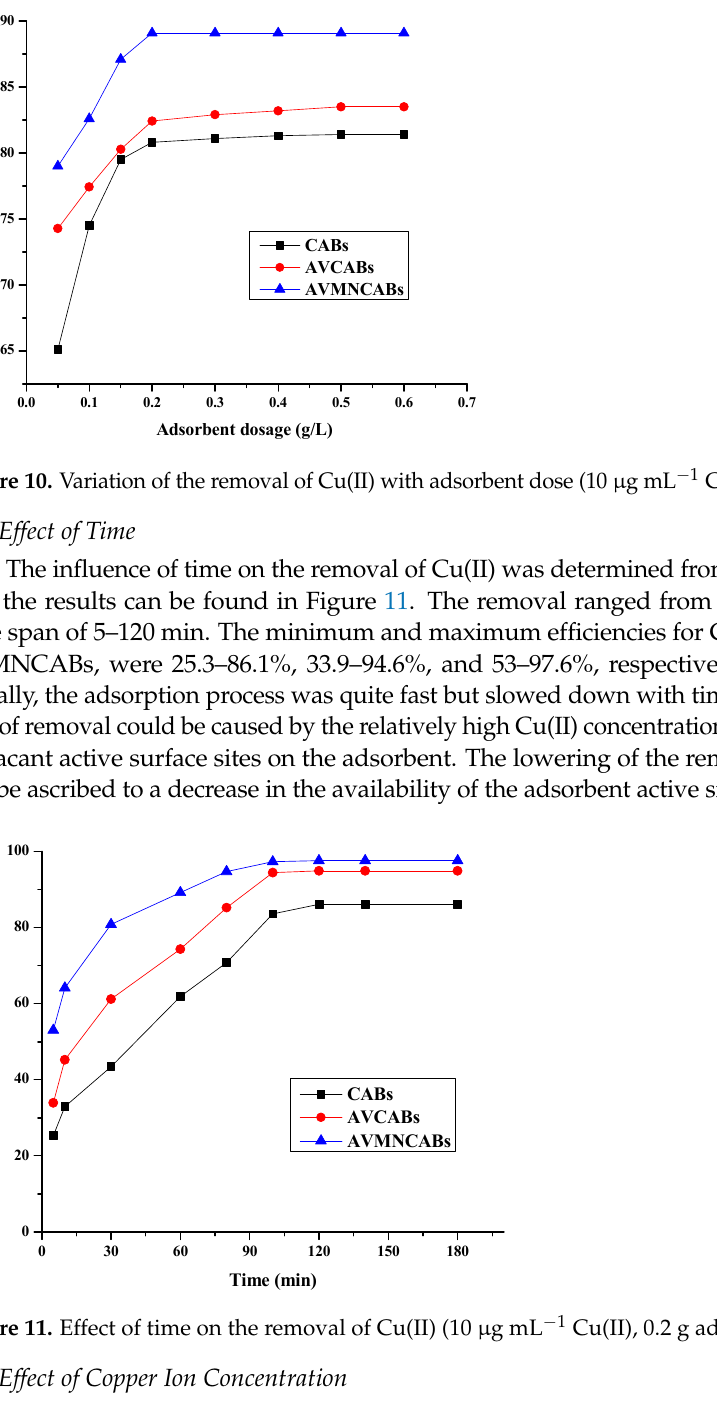
Figure 11. Effect of time on the removal of Cu(II) (10 μ g mL − 1 Cu(II), 0.2 g adsorbent; 30 °C, pH 4).